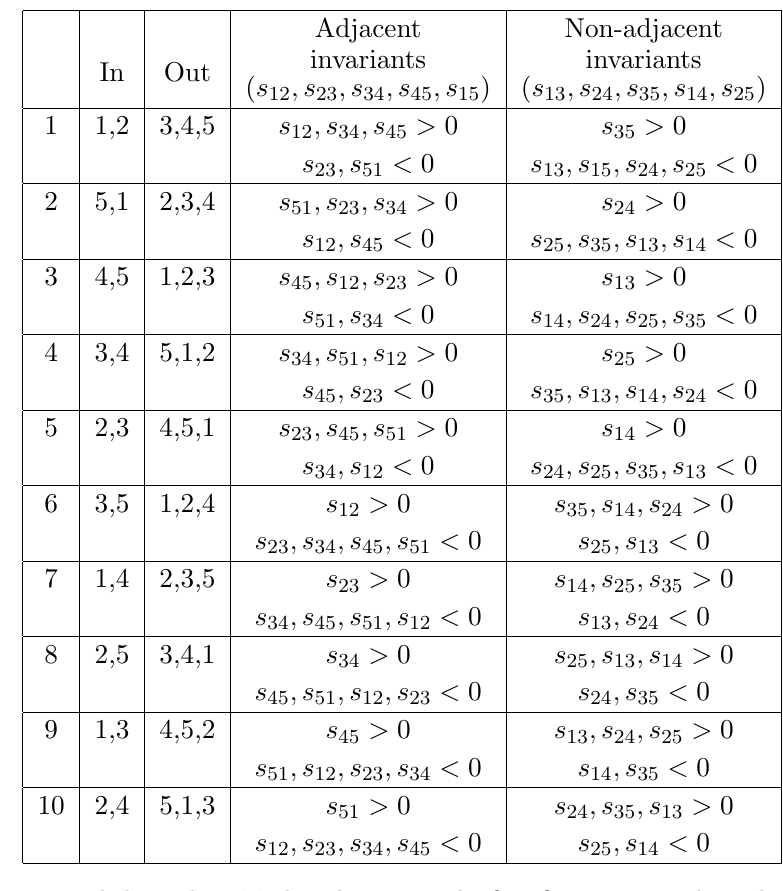
Table 1 . Kinematical channels in Minkowski region: the (cid:12)rst (cid:12)ve correspond to adjacent channels, while the remaining (cid:12)ve are non-adjacent channels.